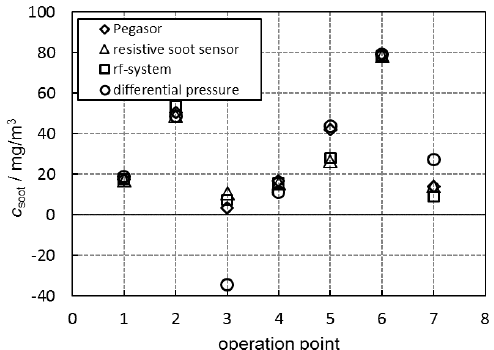
Figure 9. Comparison of all measurement devices in determining the averaged soot mass concentration, c soot , in the raw exhaust: measured with the Pegasor sensing device ( ◊ ), derived from the resistive soot sensor signal ( ∆ ), from the time derivative of the averaged microwave-derived transmission | S 21 | ( □ ) and from the time derivative of the differential pressure ∆ p ( ○ ).